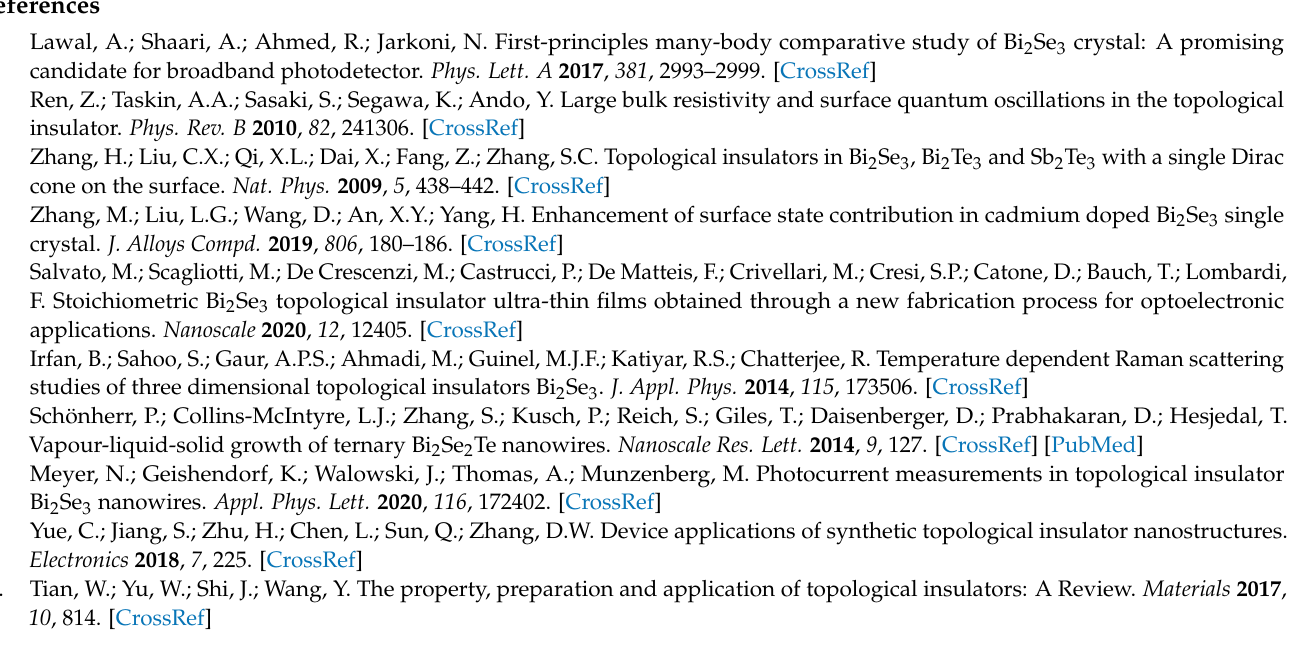
conditions, Figure S2: Schematic diagram of the photocurrent measurement system, Figure S3: FESEM cross-sectional images of ( a ) pristine, ( b ) In-, ( c ) Sn-, and ( d ) (In,Sn)-doped Bi 2 Se 3 nanoplatelets, Figure S4: Comparisons of the current in logarithmic scale vs. time under the ( a ) UV and ( b ) red light, Figure S5: FPA–FTIR absorbance and ( b ) estimated optical bandgaps of the pristine, and In-, Sn-, and (In,Sn)-doped Bi 2 Se 3 nanoplatelets, Figure S6: The estimated optical bandgaps of ( a ) pristine, and ( b ) In-, ( c ) Sn-, and ( d ) (In,Sn)-doped Bi 2 Se 3 nanoplatelets, Table S1: Lists of the Bi 2 Se 3 -based photodetectors, Table S2: Lists of the Bi 2 Se 3 doped with various elements and the variation of the bandgap